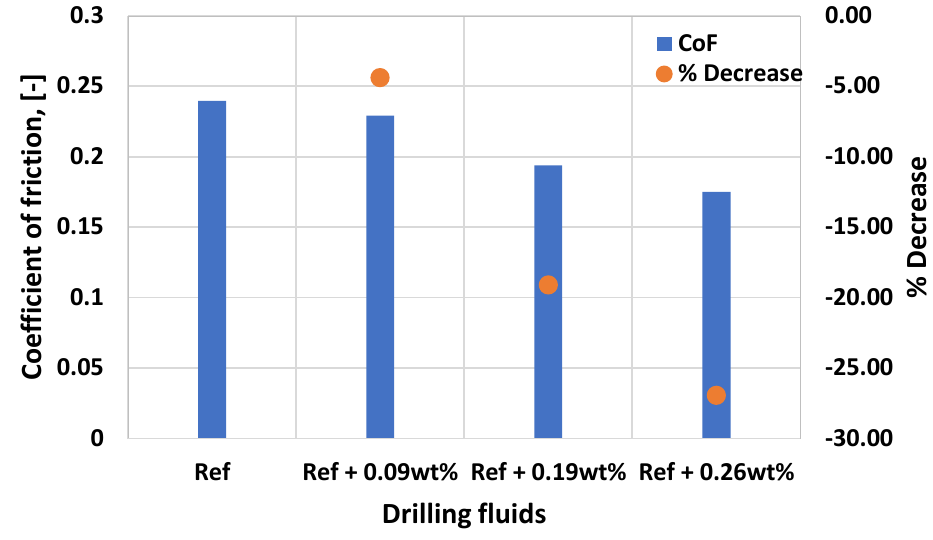
Figure 10. Effect MoS 2 on the coefficient of friction of the reference base fluid.